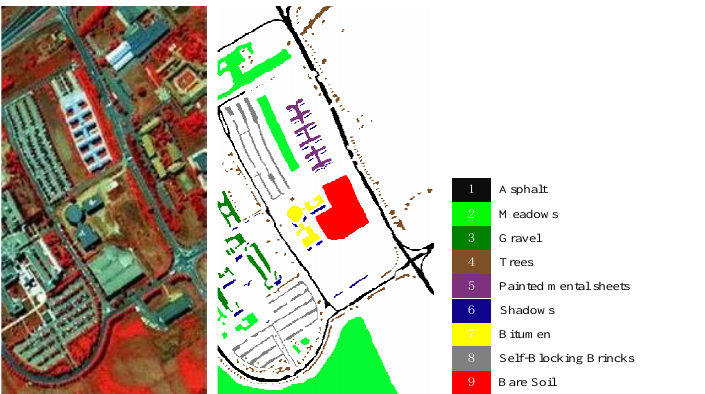
Figure 6. Ground truth map, pseudocolor images, and available samples of University of Pavia scene.